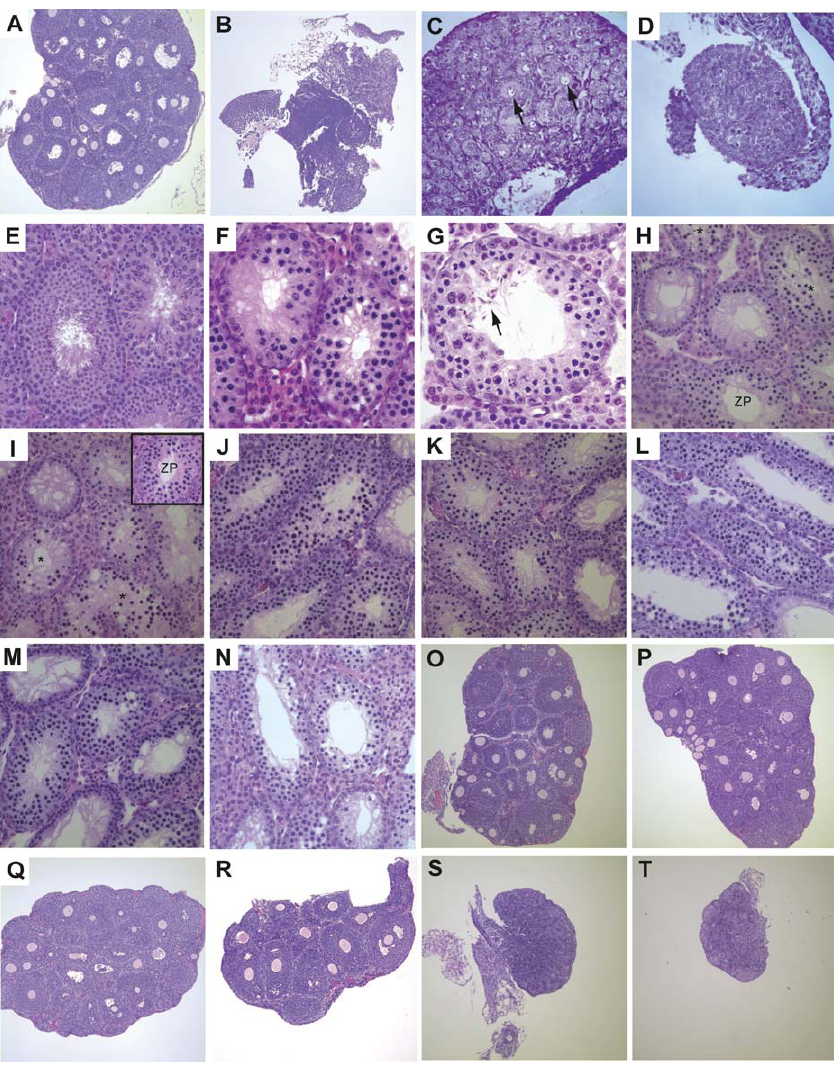
Figure 3. Histology of Mutant